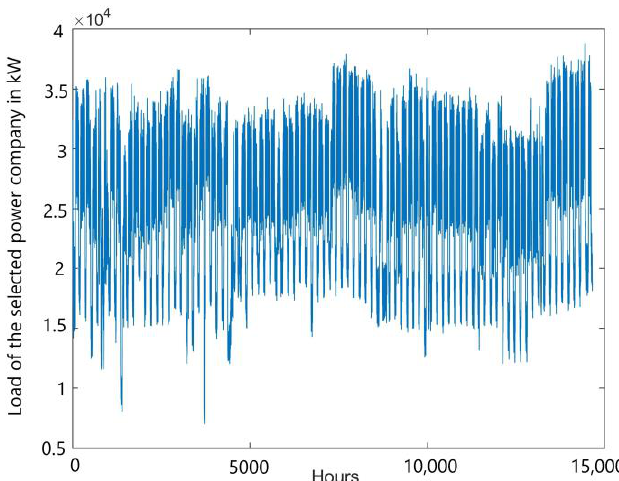
Figure 3. Load of the selected power company-chronological time series, data from 22 months, i.e., ca. 2 years (Source: own work).